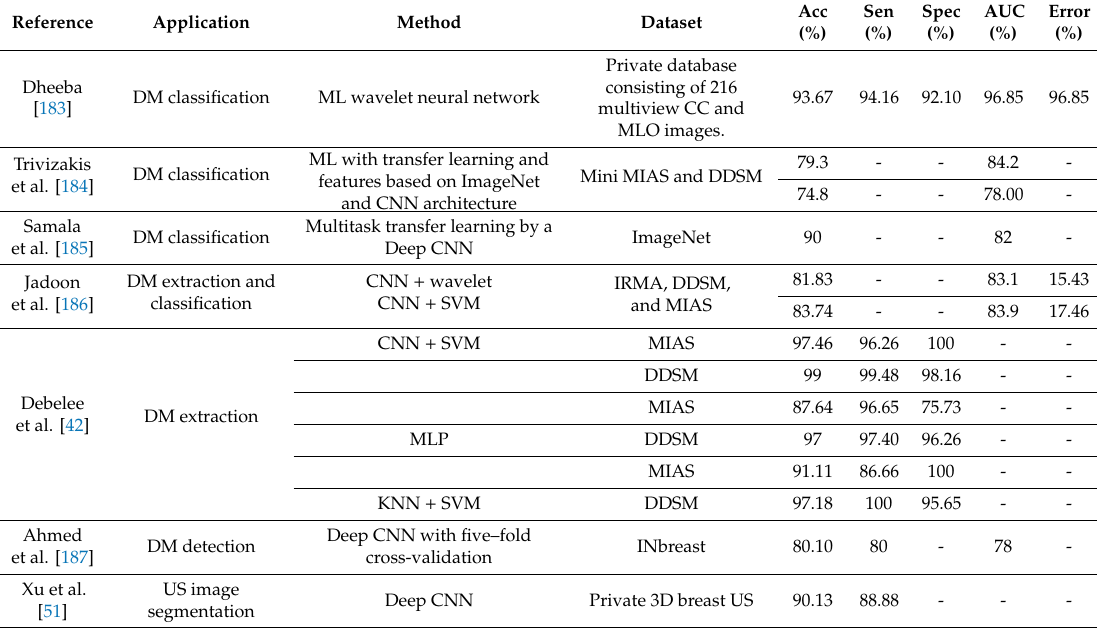
Table 8. DL-CAD systems vs. traditional ML-CAD